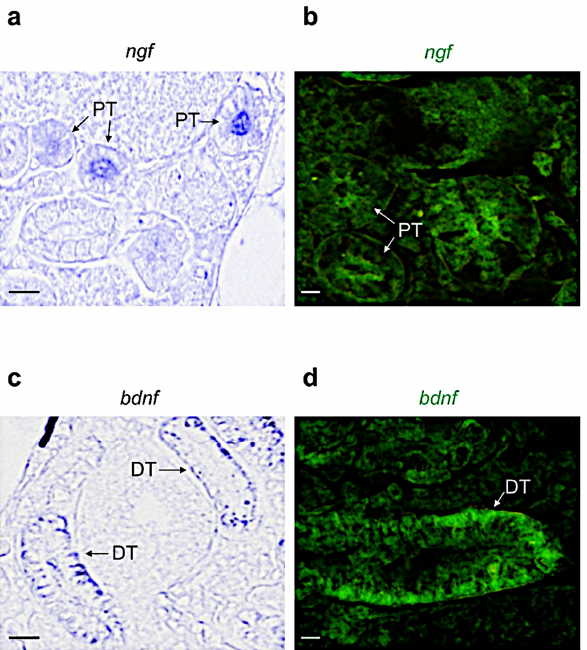
Figure 2. Chromogenic and fluorescence in situ hybridization for ngf and bdnf on cryostat and paraffin sections of adult zebrafish kidney. ( a ) Chromogenic and ( b ) fluorescence ISH for ngf-mRNA in adult zebrafish kidney; it is expressed in proximal tubules (indicated with abbreviation PT). ( c ) Chromogenic and ( d ) fluorescence ISH for Bdnf - mRNA in adult zebrafish kidney; it is expressed in distal tubules (DT). Scale bars: 100 µm ( a , c ); 50 µm ( b , d ).